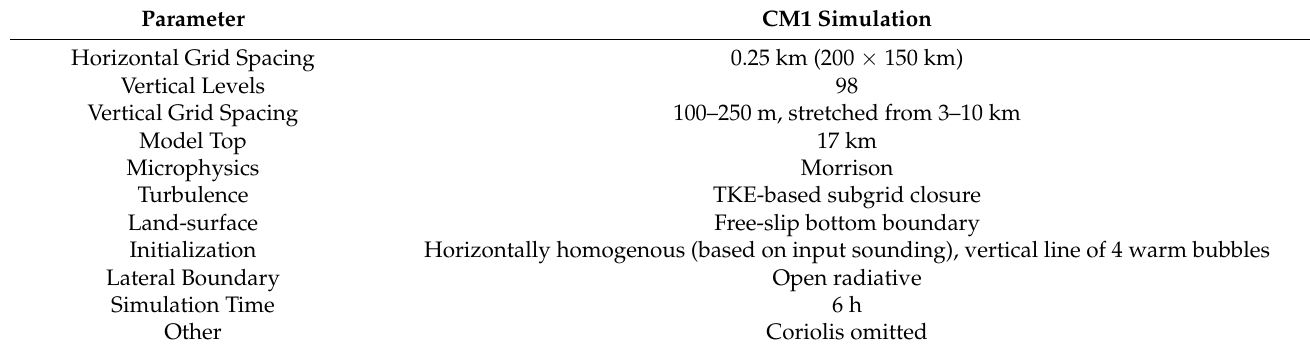
Table 2. CM1 simulation